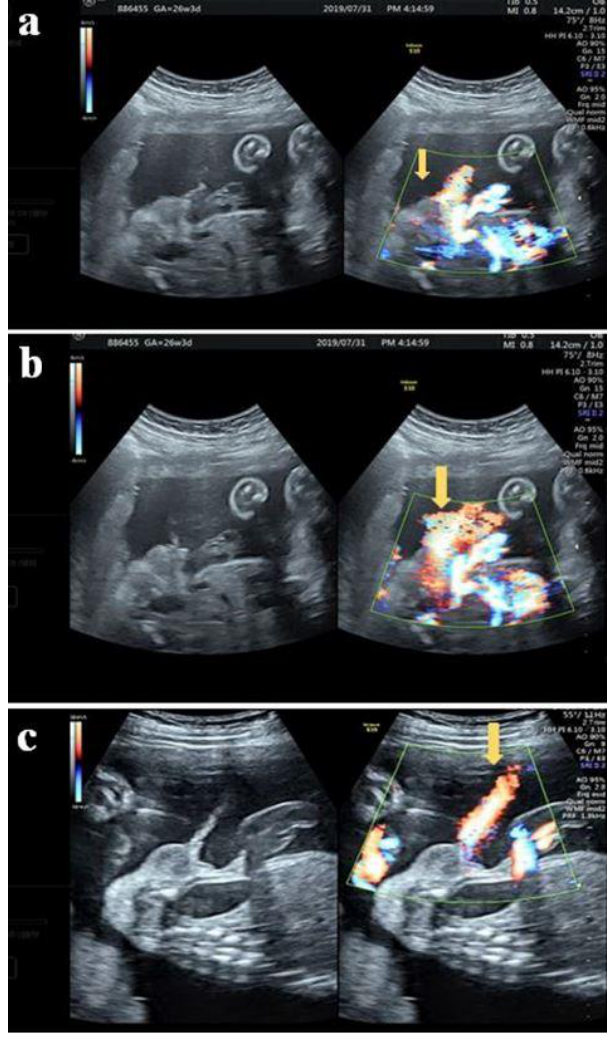
Figure 3. ( a ) The same patient at 26 + 3 weeks with stream of “coarse” urinary jets seen initially under color Doppler (arrow) ( b ) Typical fanning stream of the urinary jet revealed follows the initiated “coarse” jet of urinary stream (arrow) ( c ) Normal voiding under color Doppler with “linear” jet of stream (arrow). The patient developed preeclampsia at 34 + 5 weeks with cesarean delivery of a male baby weighing 1944 g. A first degree hypospadias was confirmed postnatal (Figure 4).